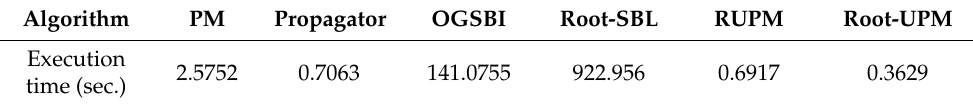
Table 2. Showing the execution time comparison of several AoA